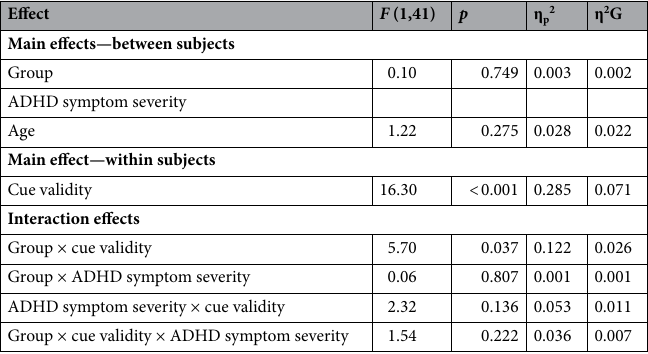
Table 8. Cue validity effect and group differences in the cue validity effect on N1pc amplitude. ADHD: Attention-Deficit/Hyperactivity